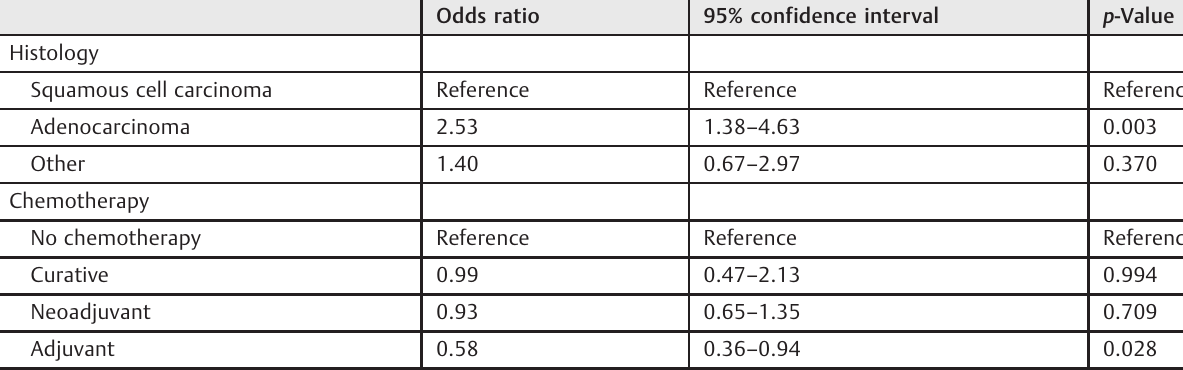
TH Open Vol. 6 No. 3/2022 © 2022. The